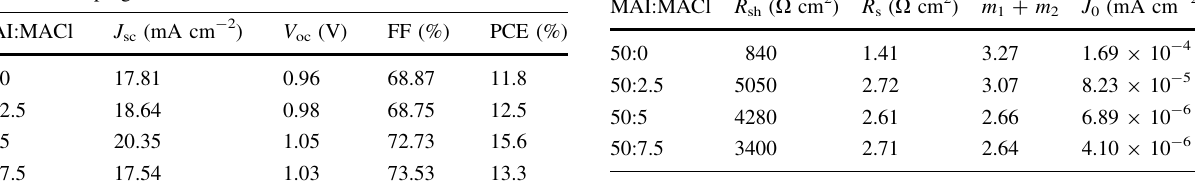
cated from doping varied MACl concentration